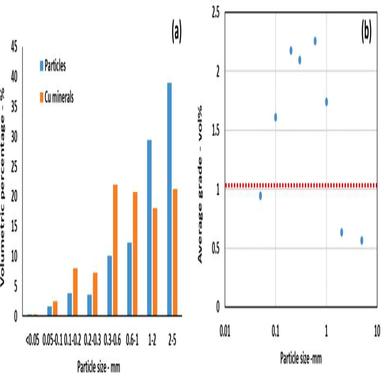
(a) distributions of particle volume and Cu mineral volume as a function of particle size. (b) average grade for each size fraction of particles where red dot line indicates the grade for the intact sample before breakage. (For interpretation of the references to color in this figure legend, the reader is referred to the web version of this article.)